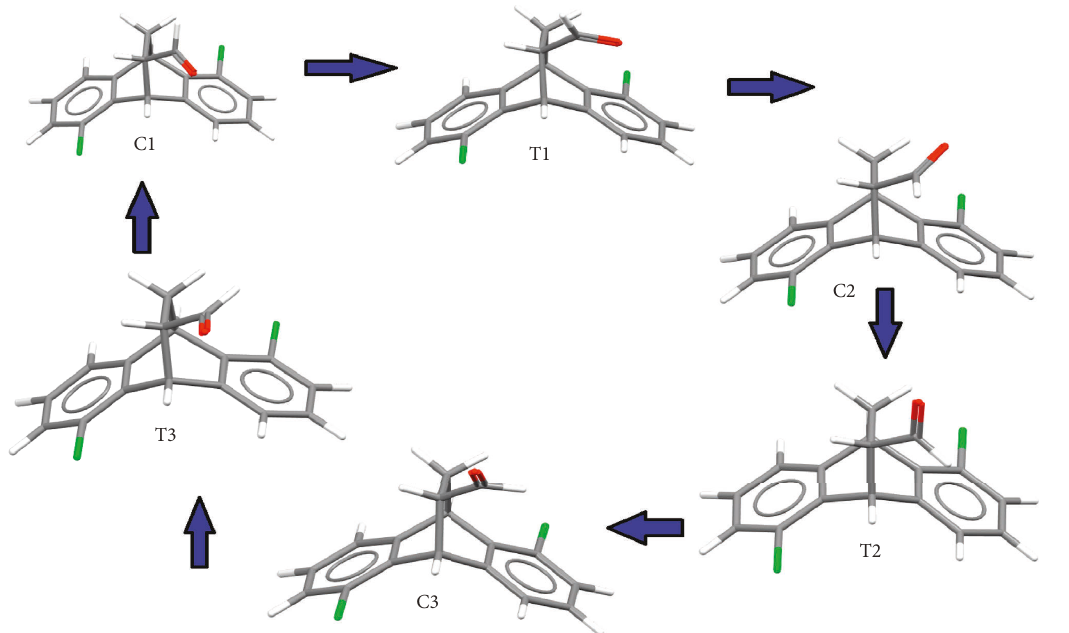
Figure 2: Conformational interconversion of the various minimum (C) and transition state (T) conformers of compound 2